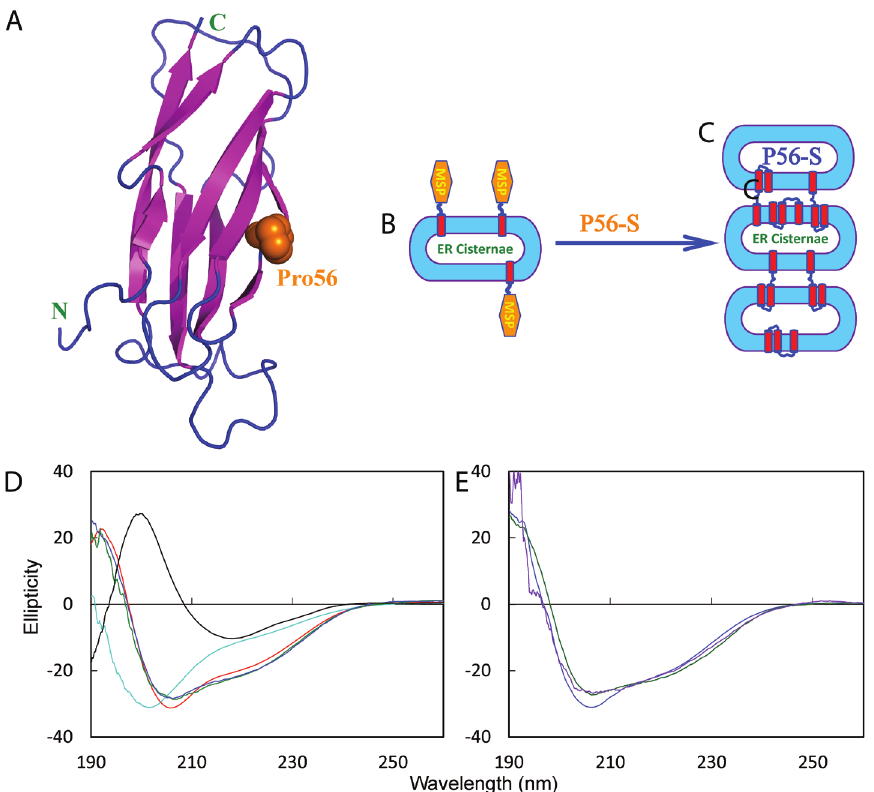
Figure 1. ALS-causing P56S mutation triggers the transformation of the all- β cytosolic MSP domain into a membrane-interacting protein which remodels ER to have stacked cisternae. A . 125-residue wild-type MSP domain adopting a seven-stranded immunoglobulin- like β -sandwich fold, with Pro56 displayed in spheres. B . The wild-type MSP domain of VAPB is anchored onto the ER membrane facing the cytosol by a C-terminal transmembrane fragment. C . The ALS-causing P56S mutant is able to remodel ER to have stacked cisternae by acquiring ability of the P56S MSP to interact with membranes. D . Far-UV CD spectrum of the wild-type MSP domain (black), typical of a β structure; and spectra of the P56S MSP in aqueous solution (cyan); in DMPC vesicle (green), bicelle formed by DMPC and DHPC (blue) as well as in DPC micelle (red) at pH 4.0. E . Far-UV CD spectra of the P56S MSP in DMPC vesicle (purple), bicelle formed by DMPC and DHPC (green) and in DPC micelle (blue) in 5 mM phosphate buffer at pH